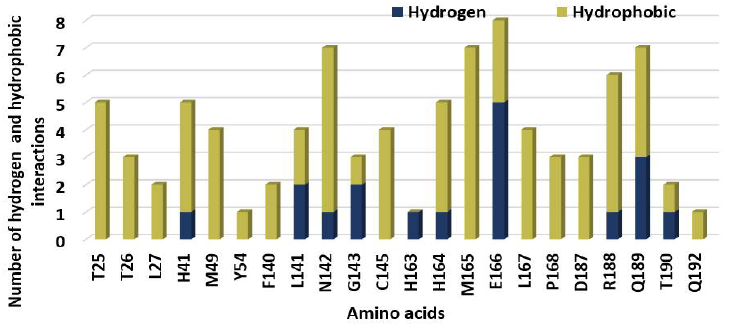
Figure 7. The number of hydrophobic interactions and H-bonds revealed upon docking of 7BQY protease against the SBs. A box-whisker plot displayed the concentration of the number of hydrogen and hy- drophobic interactions between the amino acid residues of COVID-19 and the newly syn- thesized SBs. The number of hydrogen bonds varied between the seven compounds, docked with the COVID-19 M pro pocket, with a median of 0.82. The highest number of H- bonds observed was 5 bonds for 5e , and the lowest was 1 bond for 5b , 5c , and 5f . The lowest H-bonds were 0, and the maximum value was 5 and 2 for the maximum before the upper fence. The hydrophobic interaction found between the SBs and M pro pocket ranged from 7 and 14 with average and median values of 3.14 and 3, respectively. The highest value was 14 for compound 5f with a maximum value before the fence of 7 (Figure 6, Figure S1).